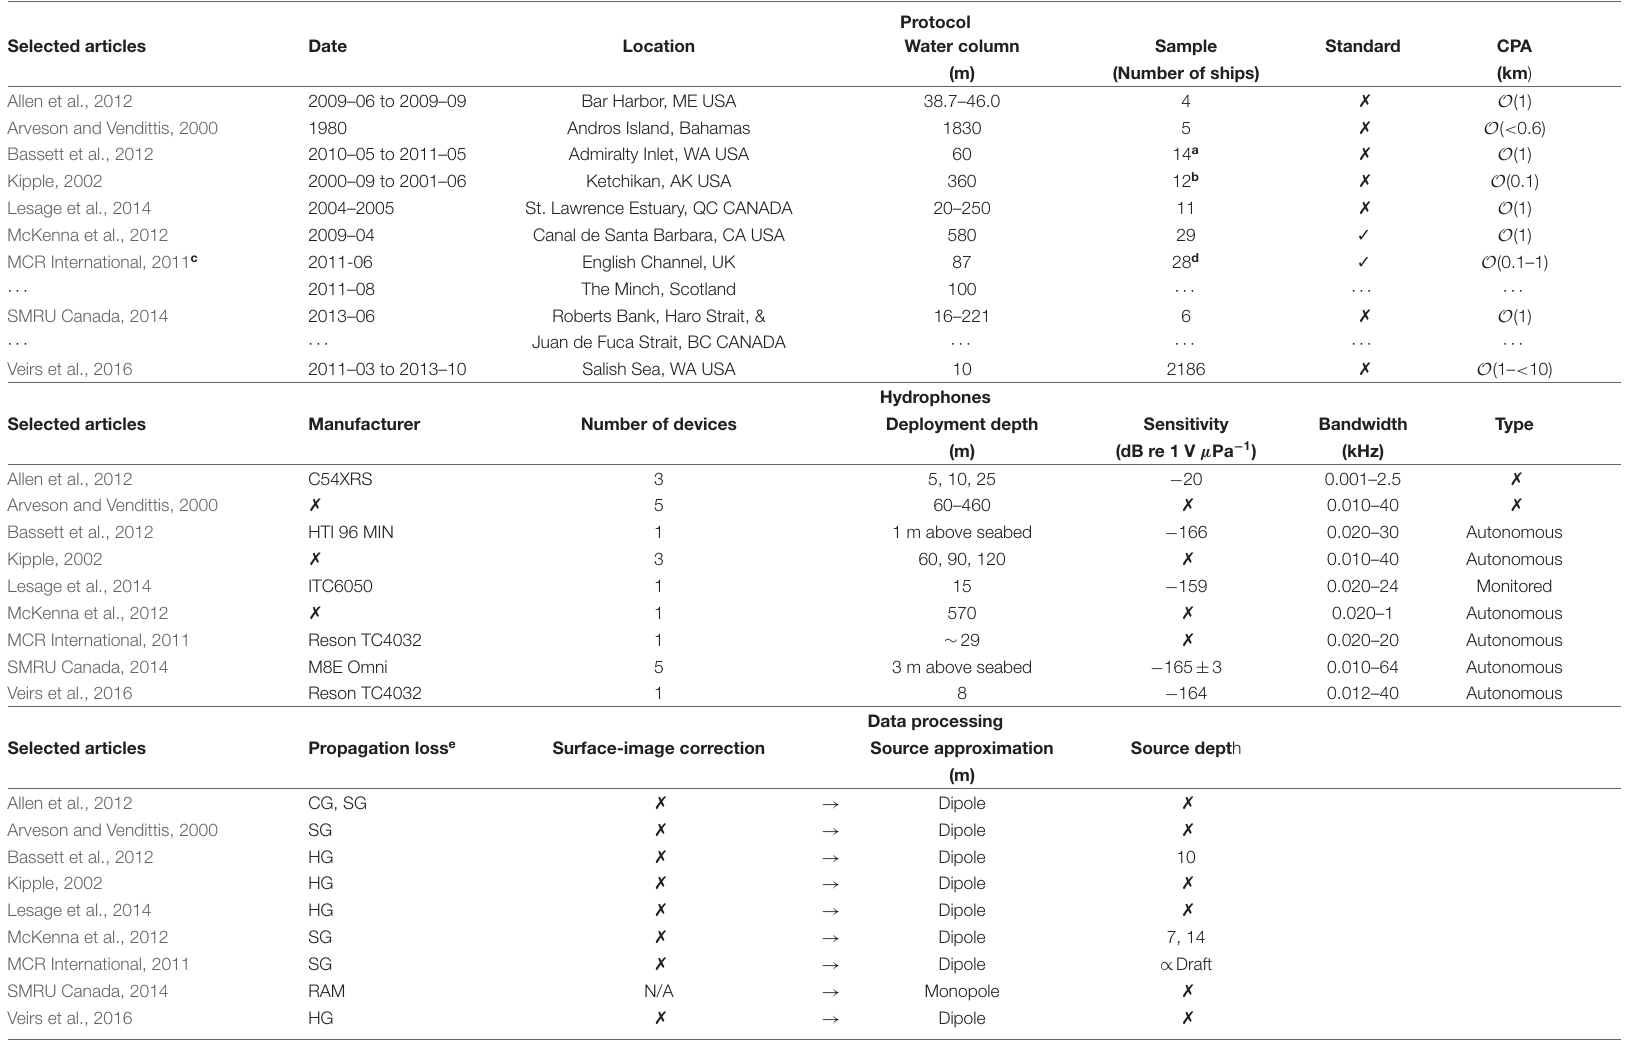
TABLE 1 | Details of the Experimental Designs and Data